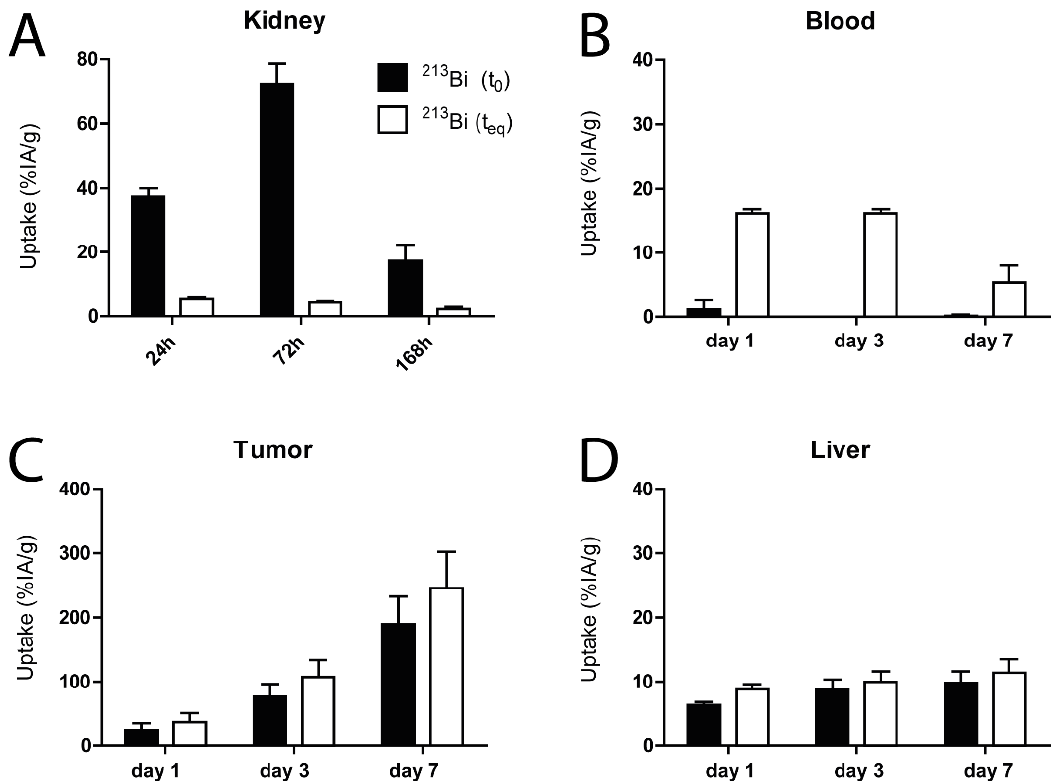
Figure 2. The calculated uptake of 213 Bi at time of dissection (t 0 ) in comparison to uptake of 213 Bi at equilibrium state (t eq : ~24 h after dissection) in organs of interest in SK-RC-52 tumor-bearing mice at 24, 72, or 168 h p.i. ( A ) Uptake in the kidneys. ( B ) Uptake in the blood. ( C ) Uptake in the tumor. ( D ) Uptake in the liver. p.i.: post injection.